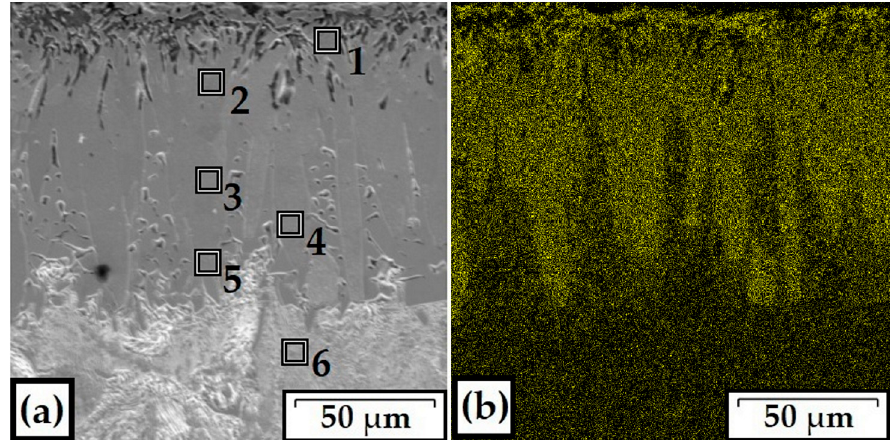
Figure 2. Microstructure ( a ) and EDS mapping ( b ) of diffusion boronized layer.